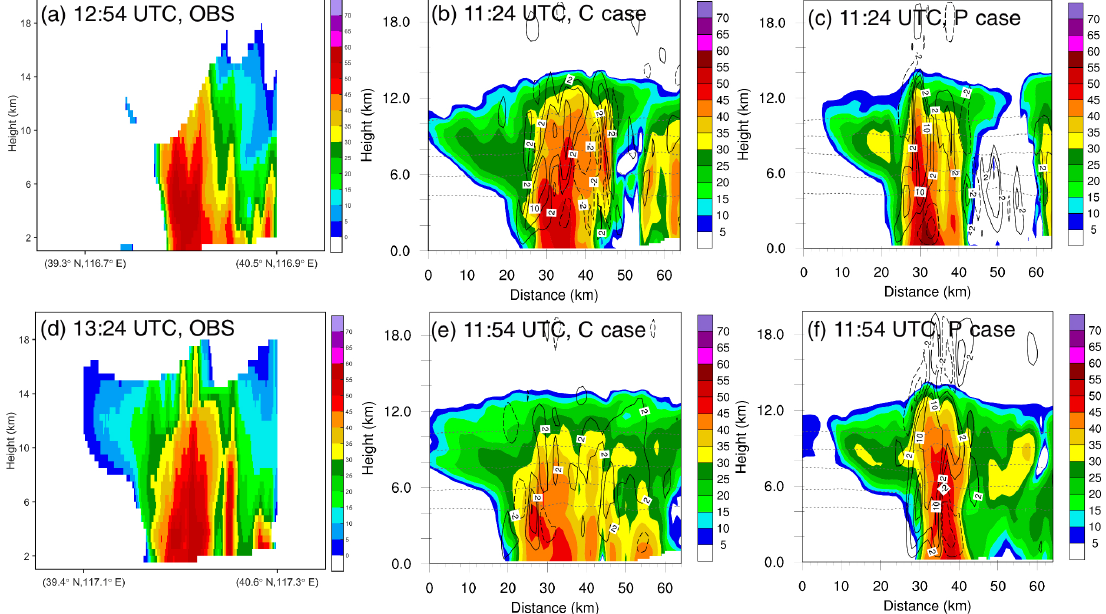
Figure 5. Comparison between observation and simulations of vertical cross section of radar reflectivity (unit dBZ) along the black line shown in Fig. 4a–f. (a) Observation (black line shown in Fig. 4a). (b) C case (black line in Fig. 4c). (c) P case (black line in Fig. 4e). (d) Observation (black line shown in Fig. 4b). (e) C case (black line in Fig. 4d). (f) P case (black line in Fig. 4f).